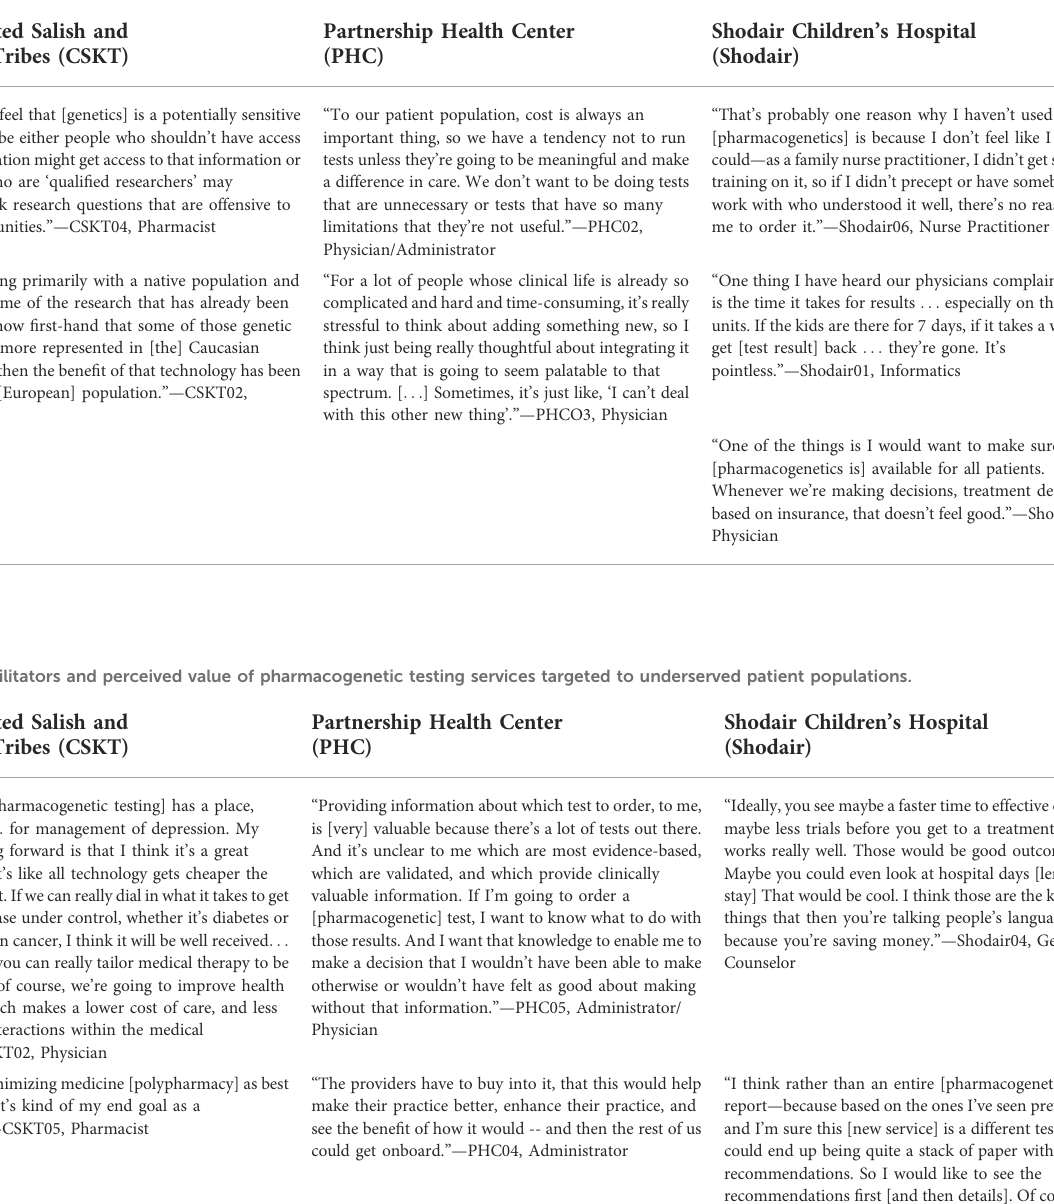
TABLE 4 Potential barriers to pharmacogenetic implementation for underrepresented populations.